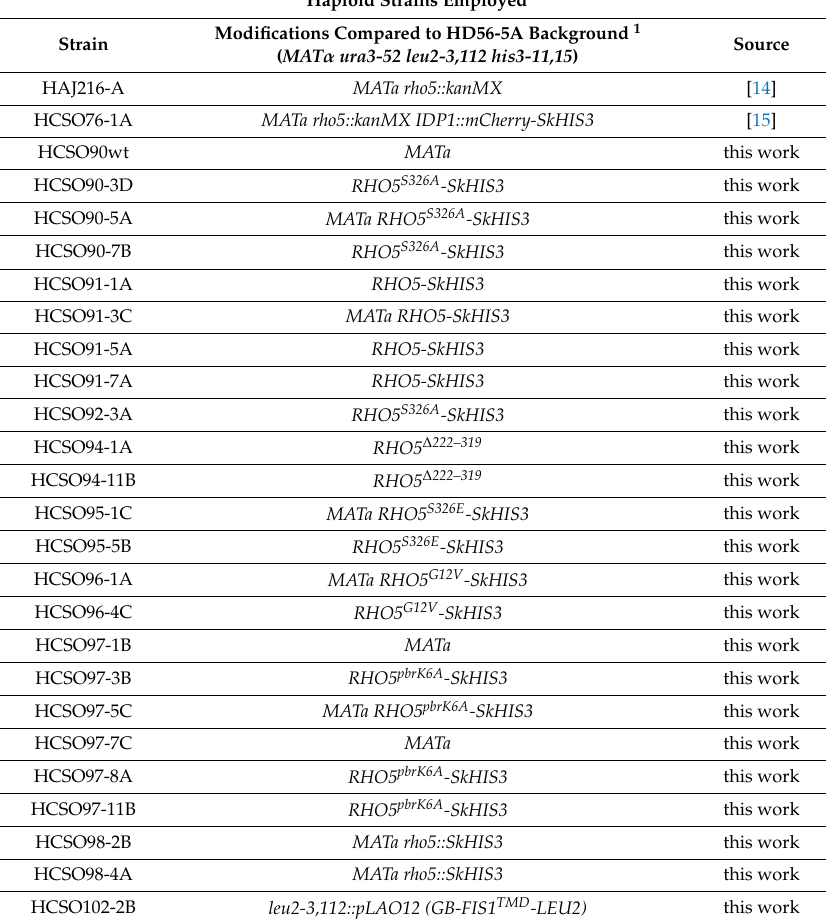
Table 1. Yeast strains used. Haploid Strains